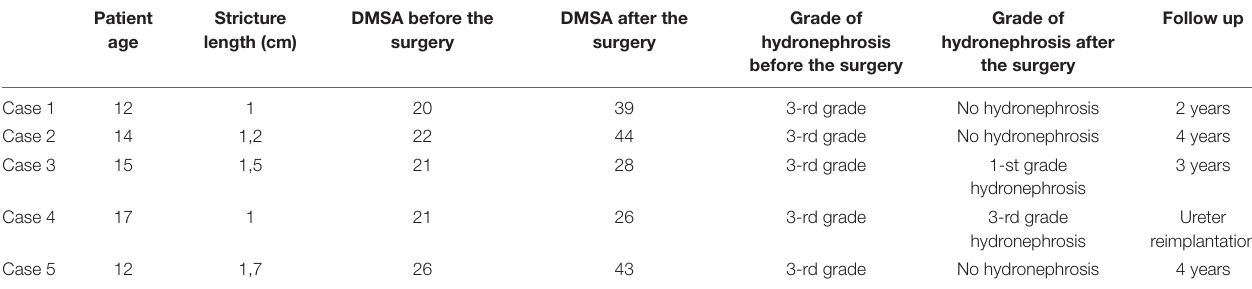
TABLE 1 | Patient series (age, length of stenosis, DMSA, degree of hydronephrosis before and after surgery, and follow-up). Patient Stricture age length